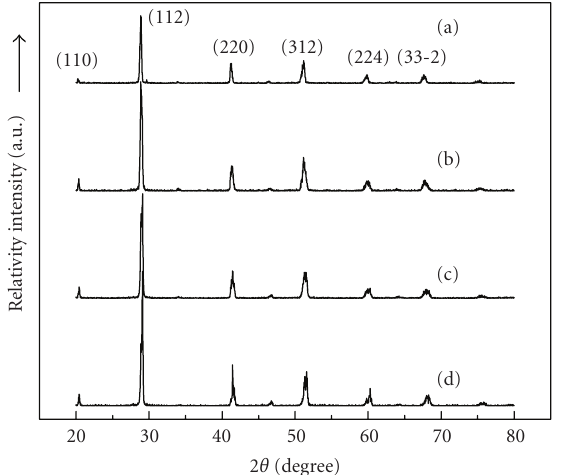
Figure 1: XRD patterns for (a) BaBi 0 . 99 La 0 . 01 O 3 , (b) BaBi 0 . 97 La 0 . 03 O 3 , (c) BaBi 0 . 95 La 0 . 05 O 3 , and (d) BaBi 0 . 90 La 0 . 10 O 3 .